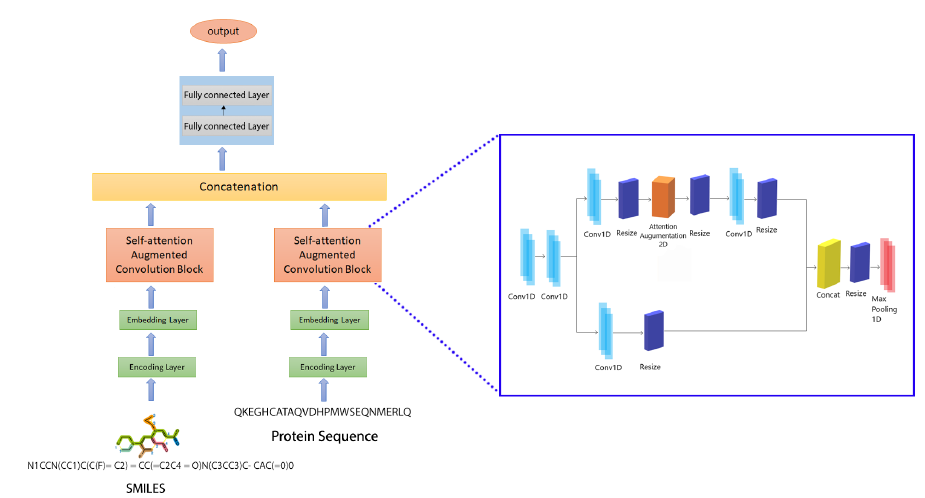
Figure 5. The proposed model’s